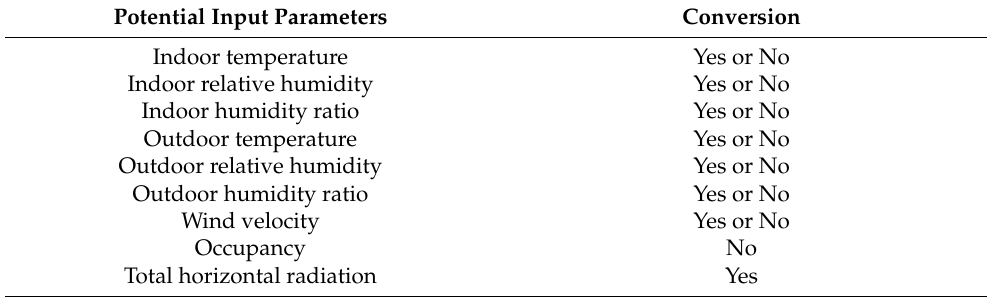
Table 2. Detailed experiment